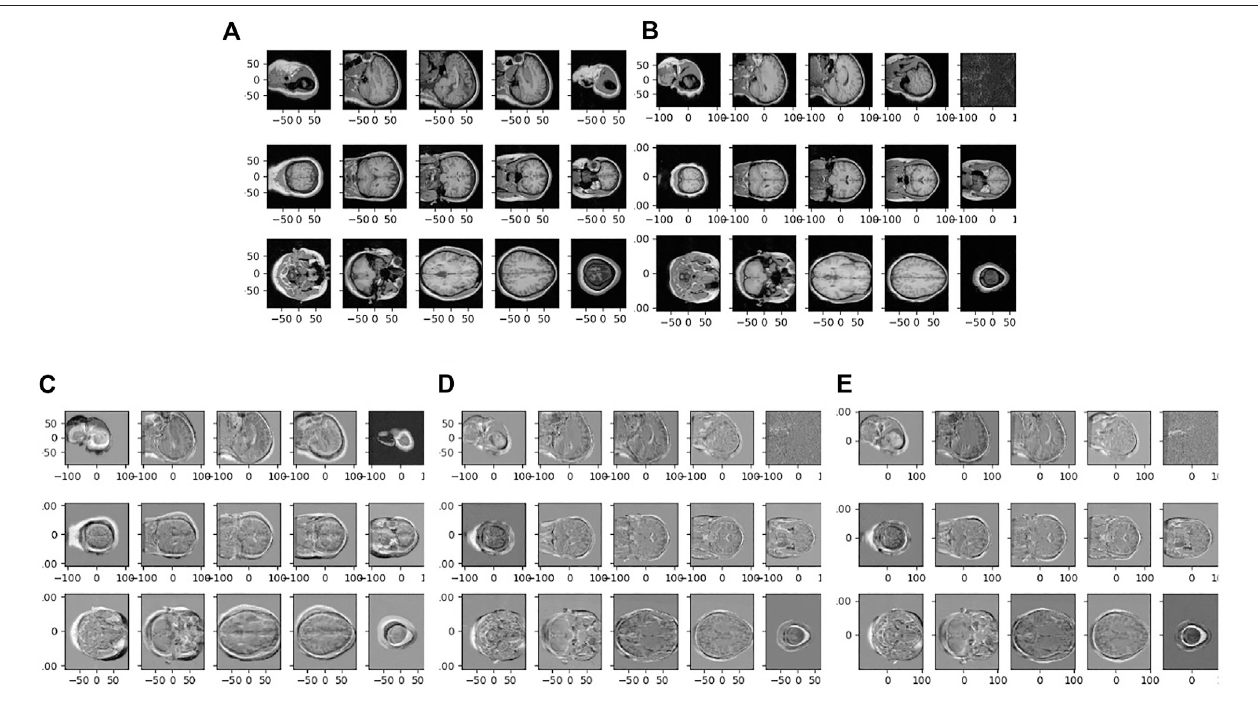
FIGURE 1 | (A, B) : One example pair of neuroimages used for registration, shown using 5 slices in each of the sagittal (top row) coronal (middle row) and axial (bottom row) planes. Difference between atlas and target images is shown before registration in (C) , after af fi ne registration in (D) , and after rigid registration in (E)